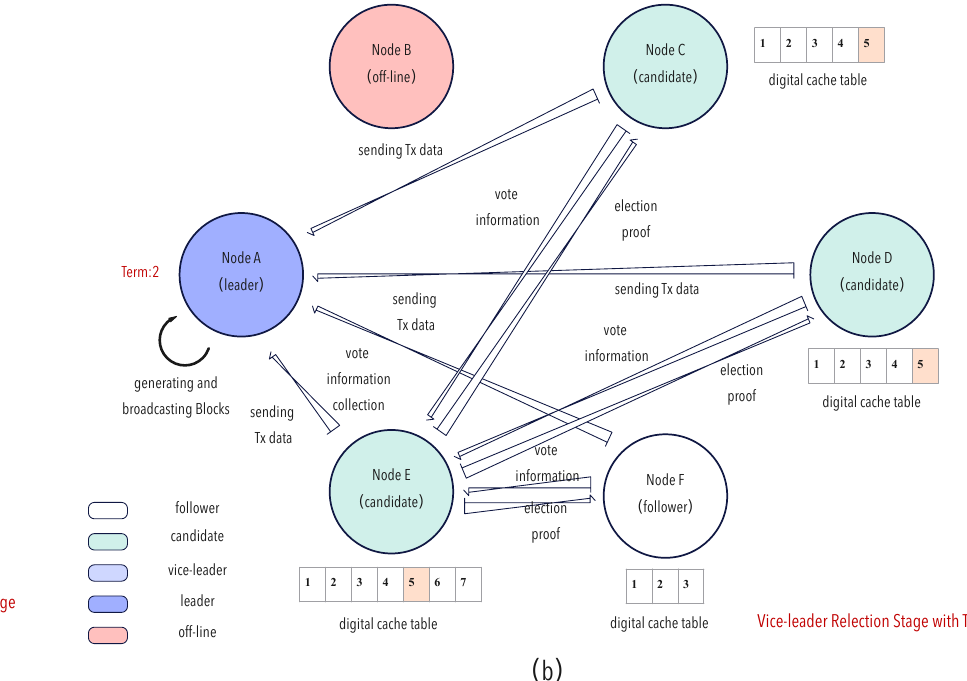
Figure 4. Consensus flow chart: ( a ) normal working stage with TERM 1; ( b ) VICE-LEADER reelection stage with TERM